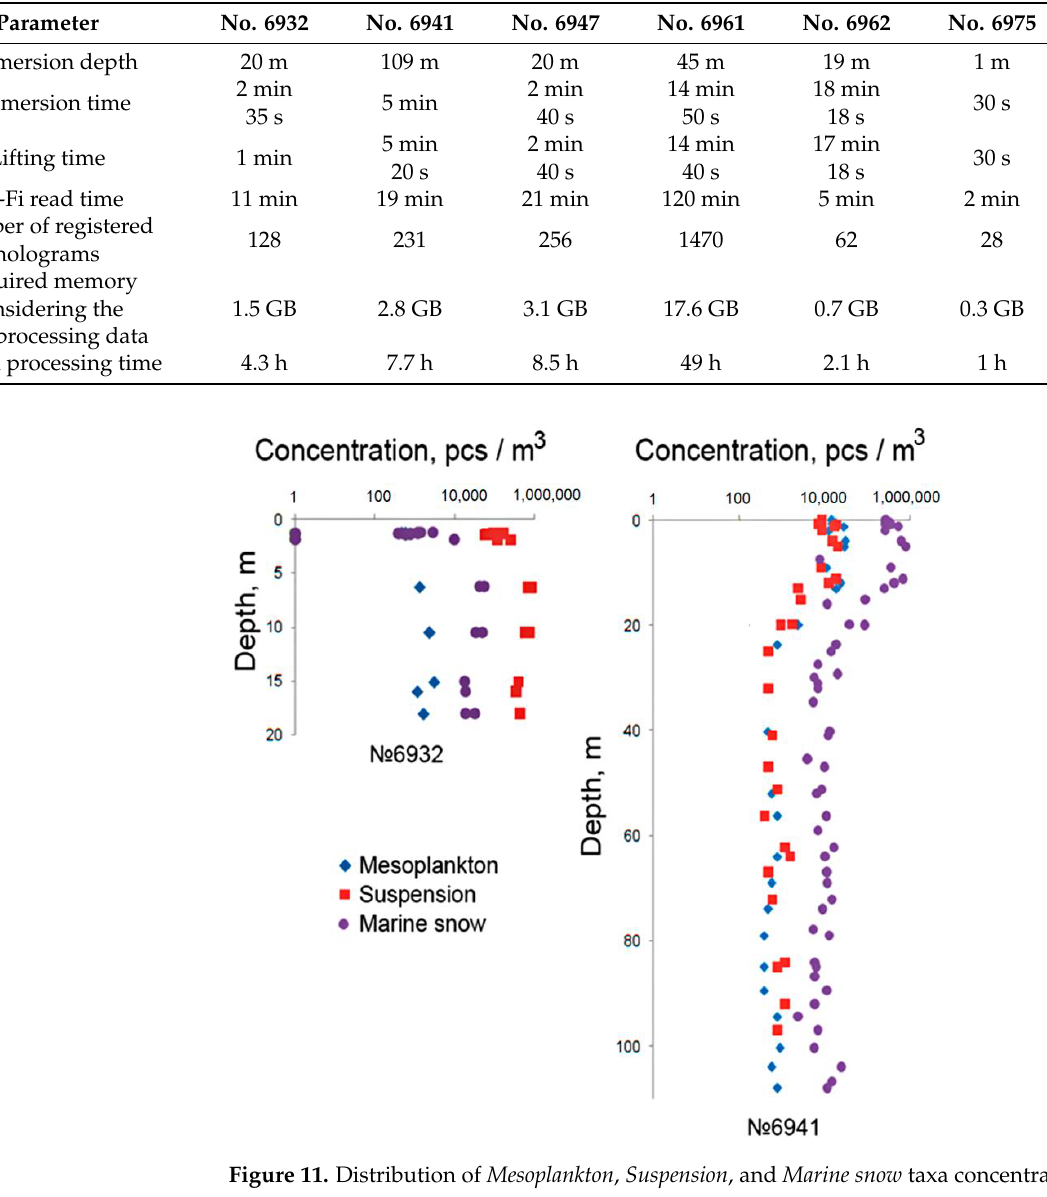
Table 4. General performance of the DHC probe.